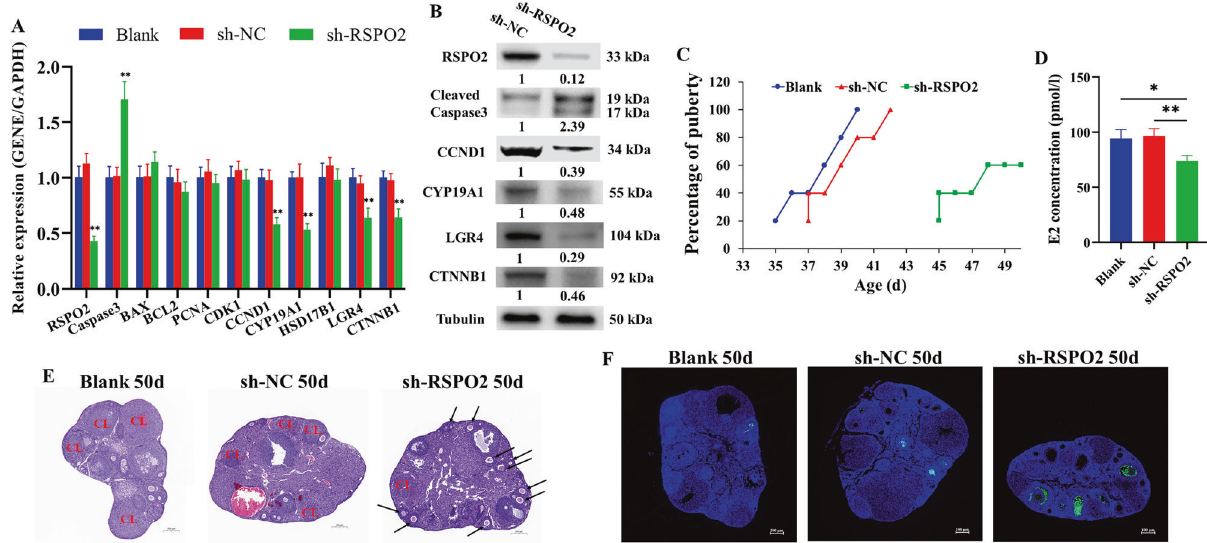
Fig. 6 Silencing RSPO2 blocked the follicular development and onset of puberty in mice. A , B The mRNA ( A ) and protein ( B ) expression levels of RSPO2 , Caspase3 , cleaved Caspase3 , CCND1 , CYP19A1 , LGR4 , and CTNNB1 in the ovaries of mice with RSPO2 inhibition. The numbers below bands were folds of band intensities relative to control. The band intensities were measured by ImageJ and normalized to Tubulin. C The percentage of mice at vaginal opening in the blank, sh-NC, and sh- RSPO2 groups ( n = 5). D The E2 concentration in serum from blank, sh-NC and sh- RSPO2 -injected mice collected at age 50 days was detected by ELISA. E Example of the ovaries from blank, sh-NC, and sh- RSPO2 - injected mice collected at age 50 days. CL indicates corpora lutea and arrows point to example of antral follicles. F The apoptosis of follicular GCs from blank, sh-NC, and sh- RSPO2 -injected mice collected at age 50 days was detected by TUNEL. * P < 0.05, ** P <